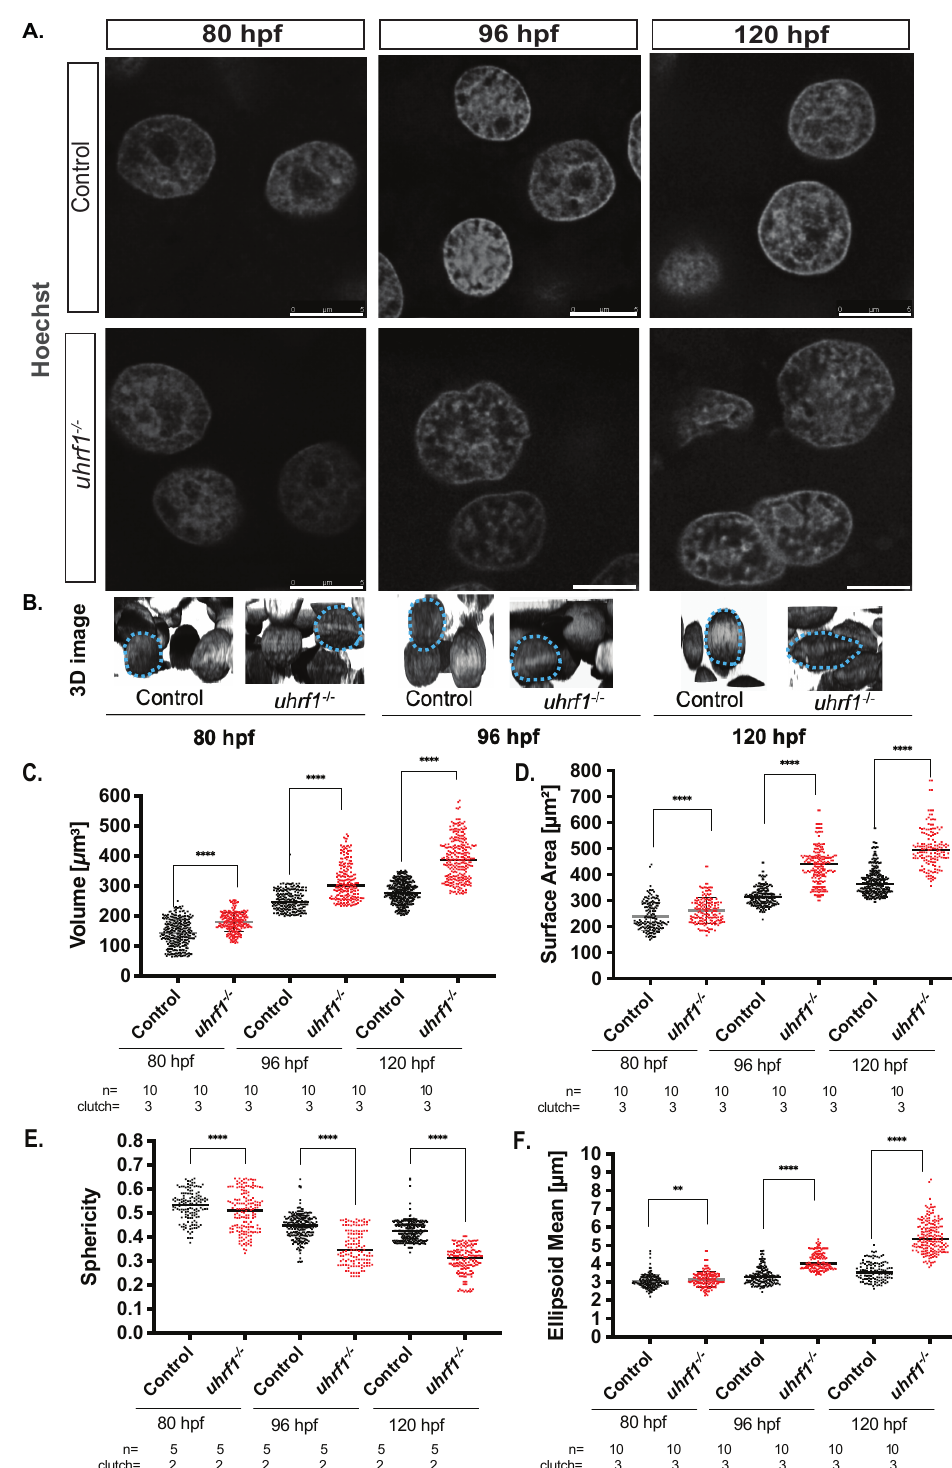
Figure 5. uhrf1 loss increases hepatocyte nuclear size, disrupts nuclear morphology, and increases nucleoli number at 120 hpf. ( A ). Confocal images of phenotypically WT siblings and uhrf1 − / − nuclei stained by Hoechst (in grey). ( B ). The 3D reconstructed nuclei in the liver of 80, 96, and 120 hpf WT siblings and uhrf1 − / − nuclei larvae display changes in size and shape at all time points between controls and mutants. ( C – F ). Nuclear morphological measurements of control and uhrf1 − / − hepatocyte nuclei scored at 80, 96, and 120 hpf for volume ( C ), surface area ( D ) for size measurements, and sphericity ( E ), ellipsoid mean ( F ) for shape measurements. Each dot represents one cell. All analyses were performed on 2 or 3 clutches, with minimum 2 livers analyzed per clutch. ** p < 0.005, **** p < 0.00005. Magnification: 63 × , 4 × zoom, Scale bar: 5 µ